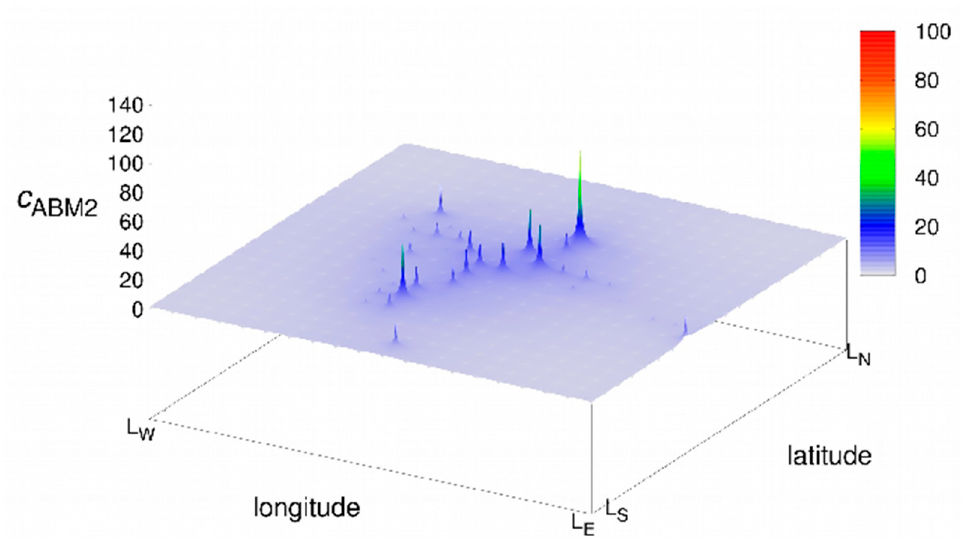
Figure 7. Distributions of agent visits based on agent-model simulations. Agents are mobile in a network with 86 nodes with 594 directed edges (not shown), configured with conditioning probabilities derived from datasets of real rickshaws on the cloud server. We removed two nodes since the counts at these two points have more values than the others: node 11 (counts = 179) and node 231 (counts = 3196).